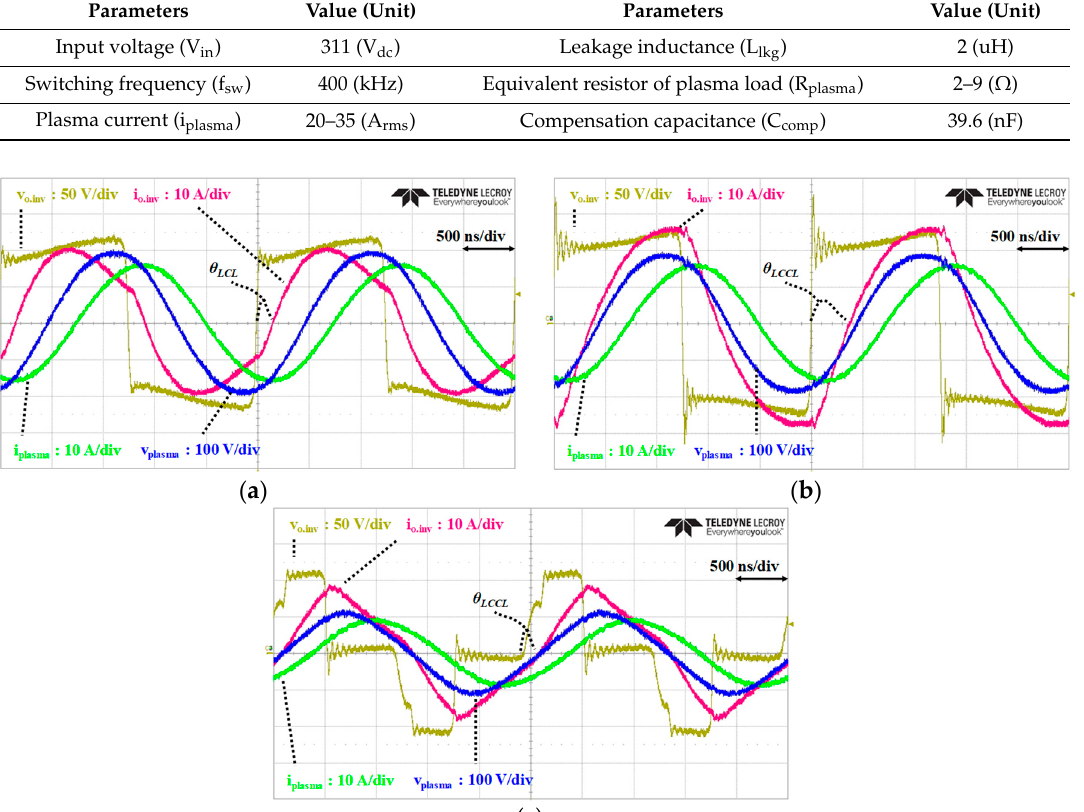
Table 1. Parameters of the inverter and both resonant networks for simulation and experiment.